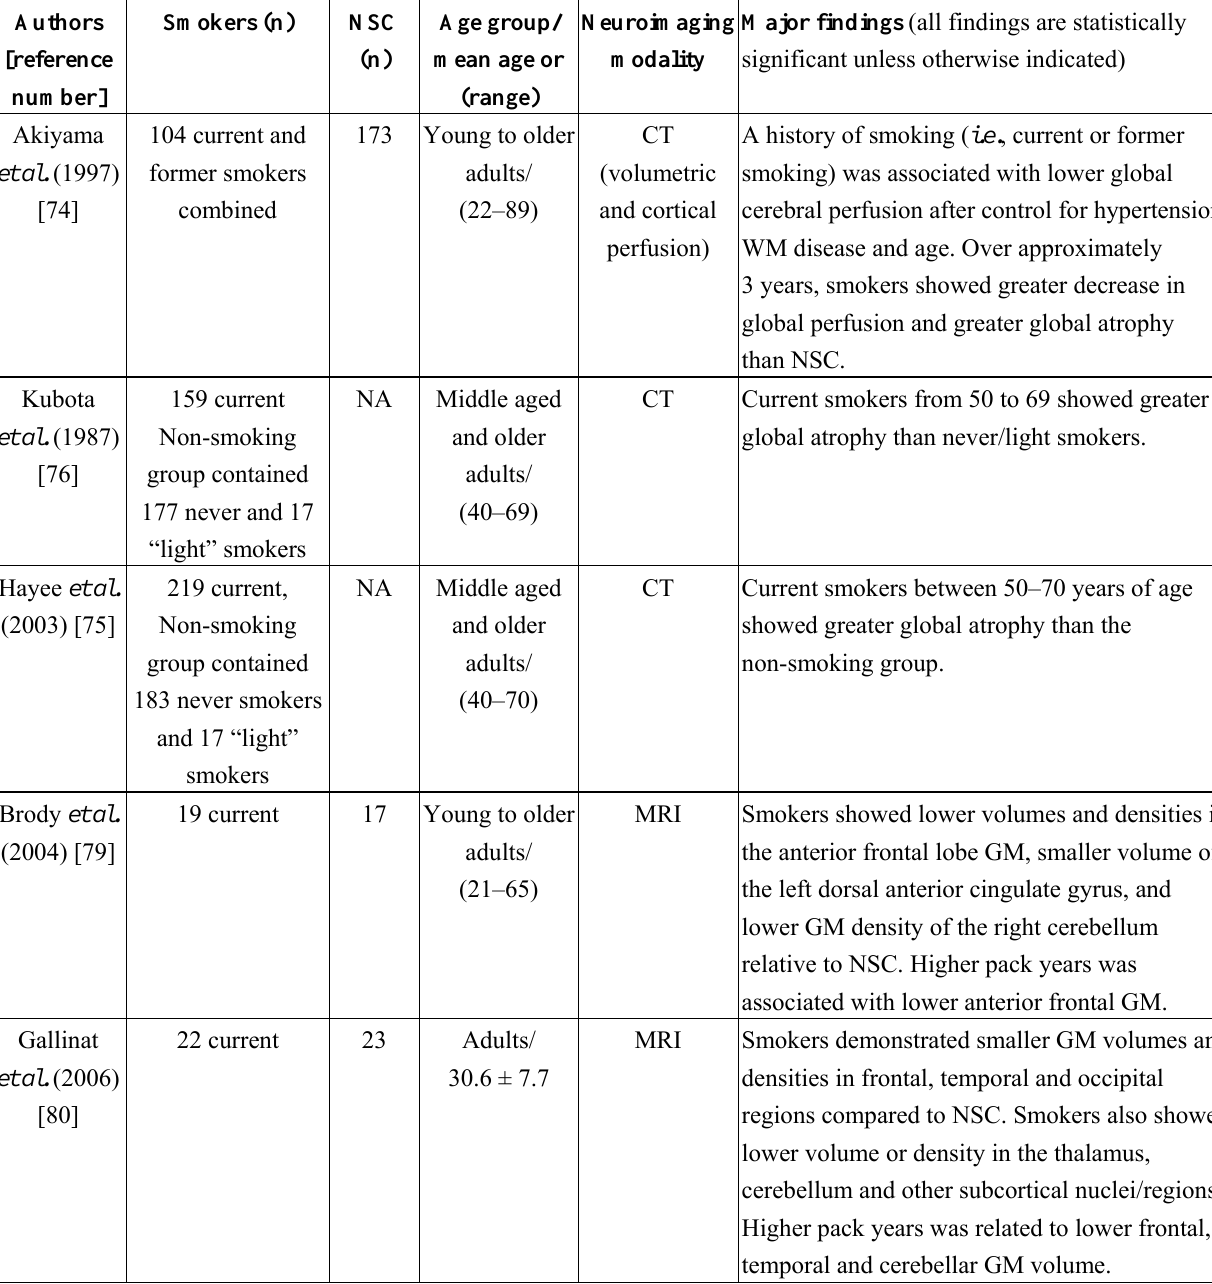
Table 2. Computerized tomography and magnetic resonance neuroimaging studies of chronic smoking in adults (sorted by imaging modality, then age